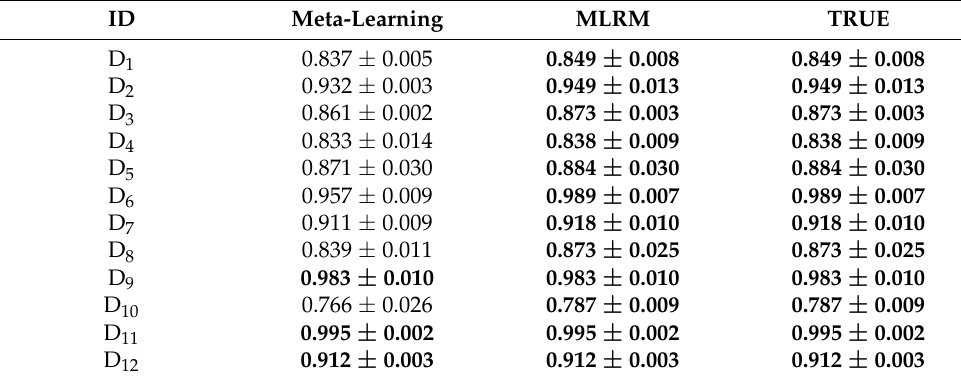
Table 11. Accuracy comparison between MLRM and meta-learning in